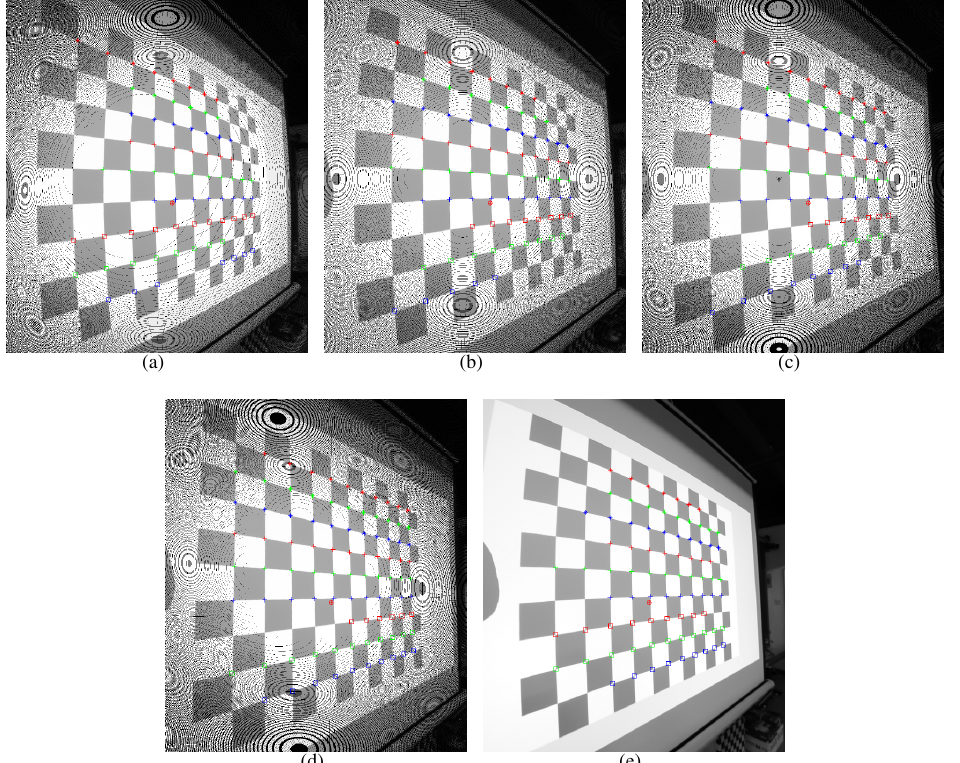
Figure 6: The corrected corner points at the horizontal direction using the RT model (a),FET model (b),PFET model (c),RF model (d),division model